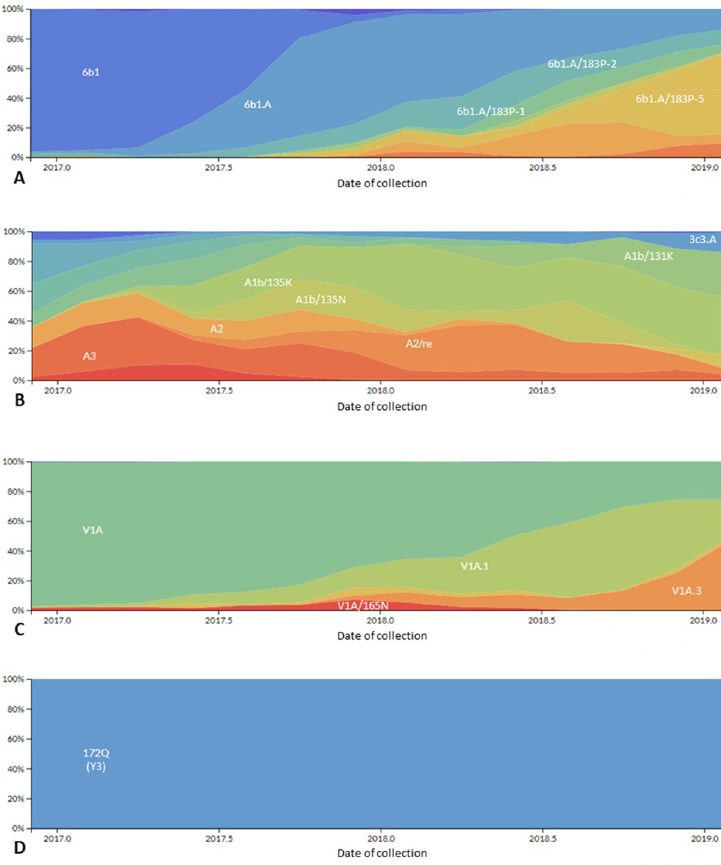
Fig 7. Frequency of genetic groups of globally circulating influenza viruses A/H1pdm09 (A), A/H3 (B), B/Victoria (C) and B/Yamagata (D) based upon hemagglutinin (HA) gene sequences from May 1, 2017 through October 26, 2018 obtained through Next Strain (available at nexstrain.org/flu/seasonal), accessed September 19, 2019.